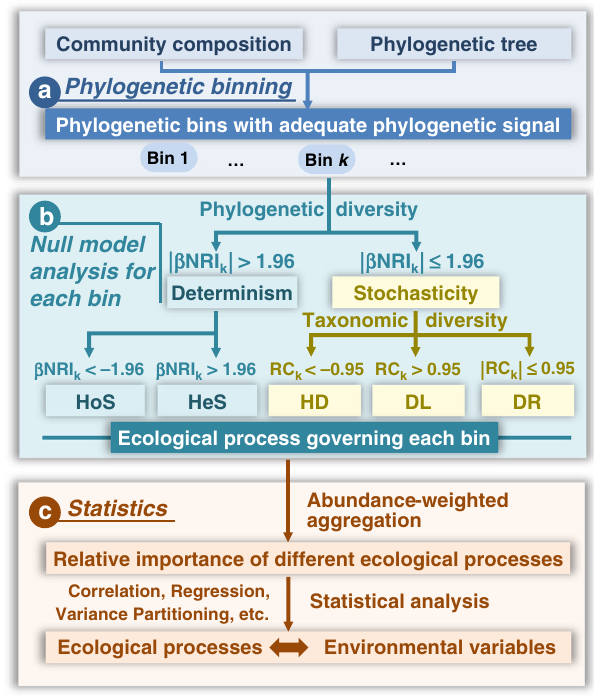
Fig. 1 Overview of iCAMP. iCAMP includes several key steps: a phylogenetic binning; b bin-based null model simulations with phylogenetic diversity for partitioning selection, and taxonomic diversity for partitioning dispersal and drift; and c statistical analysis for assessing relative importance of different ecological processes and linking the processes with different environmental ecological processes ’ particularly mean community assembly processes, including homogeneous selection (HoS), heterogeneous selection (HeS), homogenizing dispersal (HD), dispersal limitation (DL), and ‘ drift ’ (DR). See the main text for a detailed